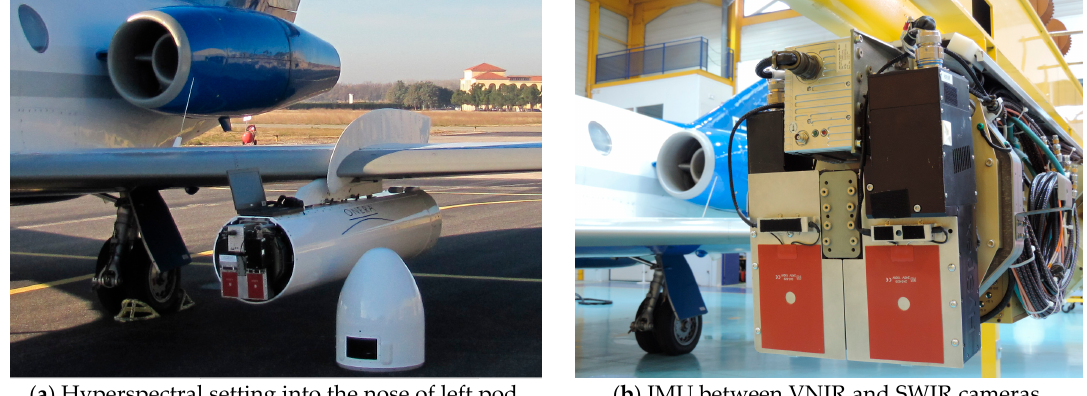
Figure 4. ( a ) Hyperspectral setting; and ( b ) Inertial Motion Unit (IMU).